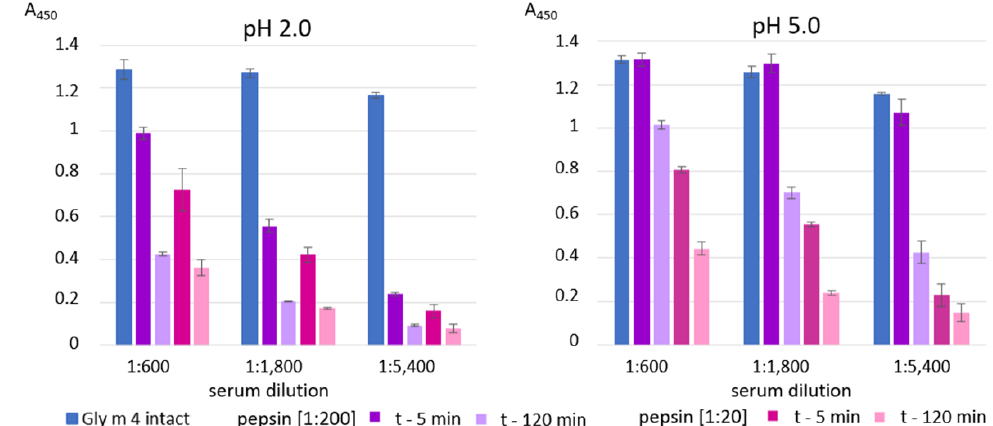
Figure 5. ELISA with the intact Gly m 4 and its gastroduodenal digests obtained at different gastric pH values (pH 2.0 and 5.0) and pepsin-to-allergen mass ratios (1:200 and 1:20) using the polyclonal rat anti-Gly m 4 IgG (t—5 min and t—120 min—time of the allergen digestion with the mixture of trypsin and α -chymotrypsin after Gly m 4 preliminary degradation by pepsin). Error bars represent standard deviation between technical replications.